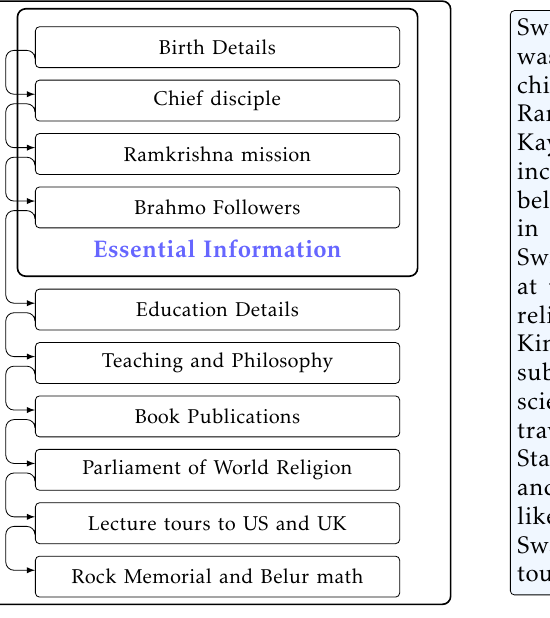
Figure 8. Organized Exhibit Information of Swami Vivekananda at URL: SV-infol3.pet.iisc.in for Professional Ubiquitous